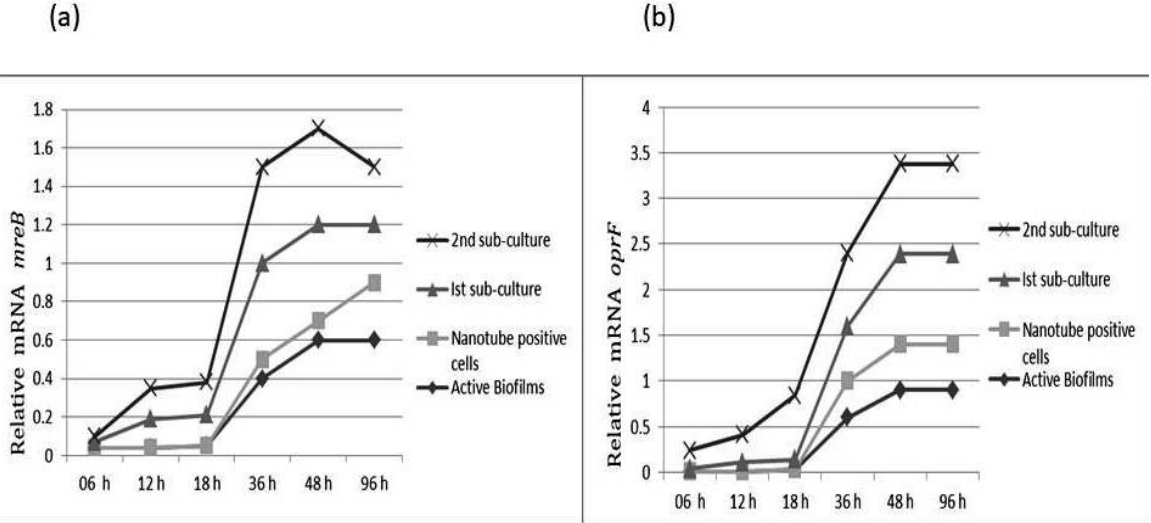
Figure 6. Relative gene expression of mreB ( a ) and oprF ( b ) of subject isolates of P. aeruginosa at different growth phases and at different time intervals. Table 1. Physical Measurements (Total volume including cell length, width and height) of 35 ran- domly selected cells from a biofilm population of 350 cells. These cells were attached to the glass surface at the lower base of the biofilm consortia. All estimates were analyzed using Gwyddion